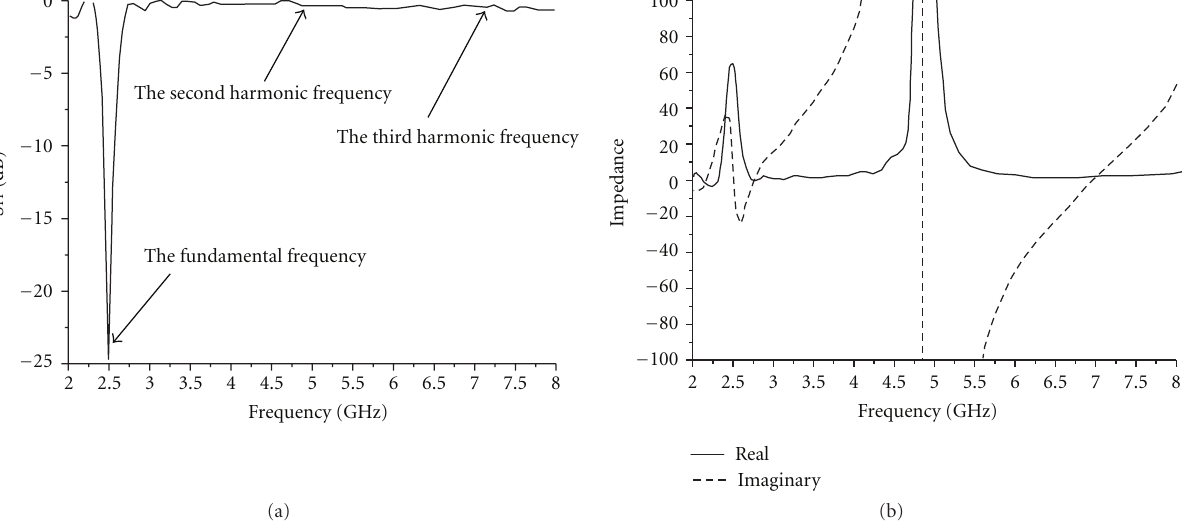
Figure 4: (a) The simulated return losses of antenna 2 and (b) The simulated input impedance of antenna